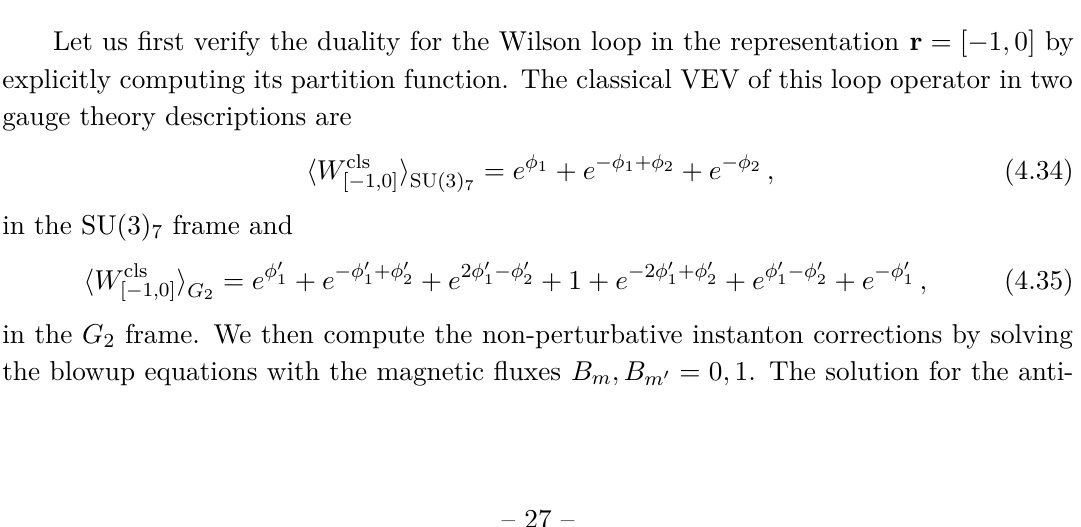
Q Q d Q − 2 / 3 i 2 3 i